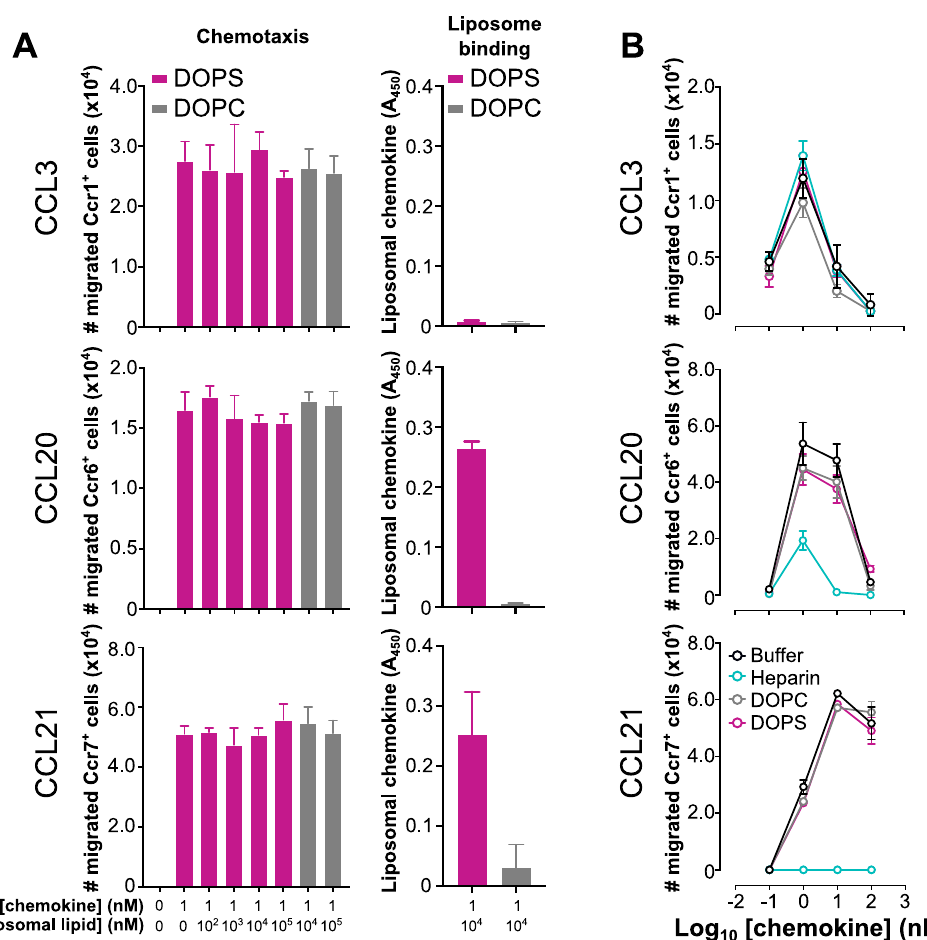
Fig 3. Chemokine interaction with liposomal PS does not affect chemotactic activity. (A) DOPS liposomes do not impair chemokine chemotactic activity. Left column: “Chemotaxis.” The chemokines indicated on the left side of each graph row were preincubated for 30 minutes at room temperature with biotinylated DOPS (magenta) or DOPC (gray) liposomes at the concentrations indicated below the x-axis. Then, chemotactic activity of the mixture was tested using L1.2 reporter cells, stably expressing the mouse receptors Ccr1 (for CCL3), Ccr6 (for CCL20), and Ccr7 (for CCL21) as indicated on the y-axis. Bars correspond to the total number of migrated cells after 3–4 hours at 37˚C for each chemokine–liposome mix or buffer alone (0:0, chemokine:liposome). Right column: “Liposome binding.” CCL20 and CCL21 but not CCL3, bound to DOPS liposomes under the experimental conditions used for the chemotaxis assays. Liposome-bound chemokine was detected by ELISA. A total of 50 μ l of the 1:10 4 chemokine:liposome molar ratio mix of each chemokine with biotinylated DOPS or DOPC liposomes (as indicated in the inset of the top graph) were incubated in streptavidin-coated wells. After washing, liposome-bound chemokine was detected by specific antibodies, and A 450 was calculated in a microplate reader. All data are presented as mean ± SD of triplicates from one experiment representative of 3 independent experiments. (B) Anionic GAGs but not PS-containing liposomes inhibit the chemotactic activity of CCL20 and CCL21. Increasing concentrations (0.1–100 nM) of CCL3, CCL20, and CCL21 (as indicated on the left side of each graph) were preincubated for 30 minutes at room temperature with buffer alone (black), or a 10 4 -fold molar excess of DOPC liposomes (gray) or DOPS liposomes (magenta), or a 10 3 -fold molar excess of heparin (cyan), as indicated in the inset of the bottom graph. Chemotactic activity for each condition is presented as the mean ± SD number of migrated cells of triplicates from one experiment representative of 2–3 independent experiments. The underlying numerical values for the panels displaying summary numerical data can be found in S1 Data. GAG, glycosaminoglycan; PS,